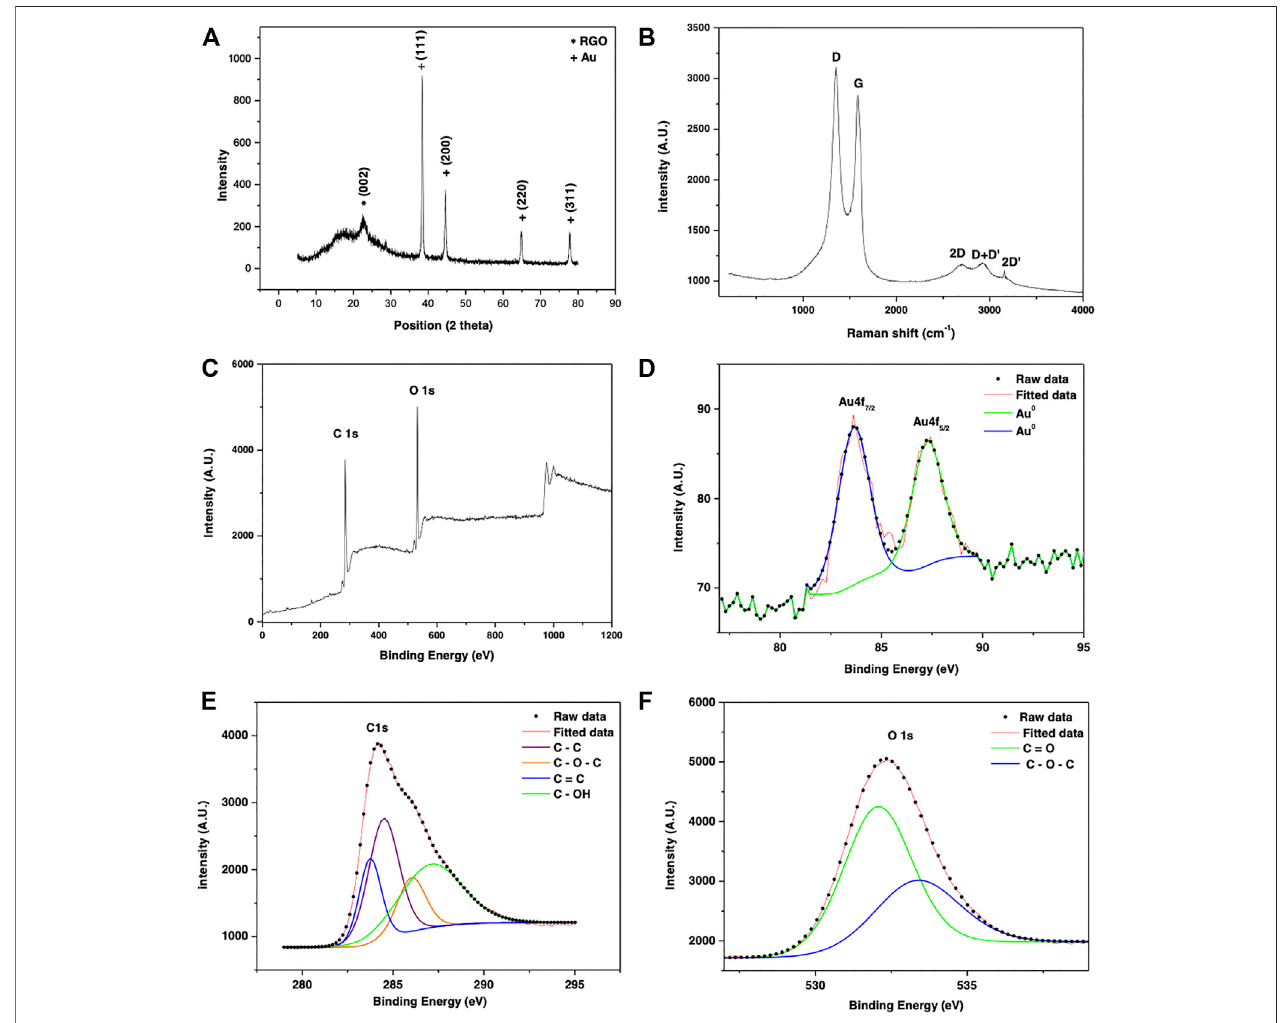
FIGURE 2 | (A) XRD pattern (B) Raman and (C – F) XPS spectra of the as synthesized graphene-Au